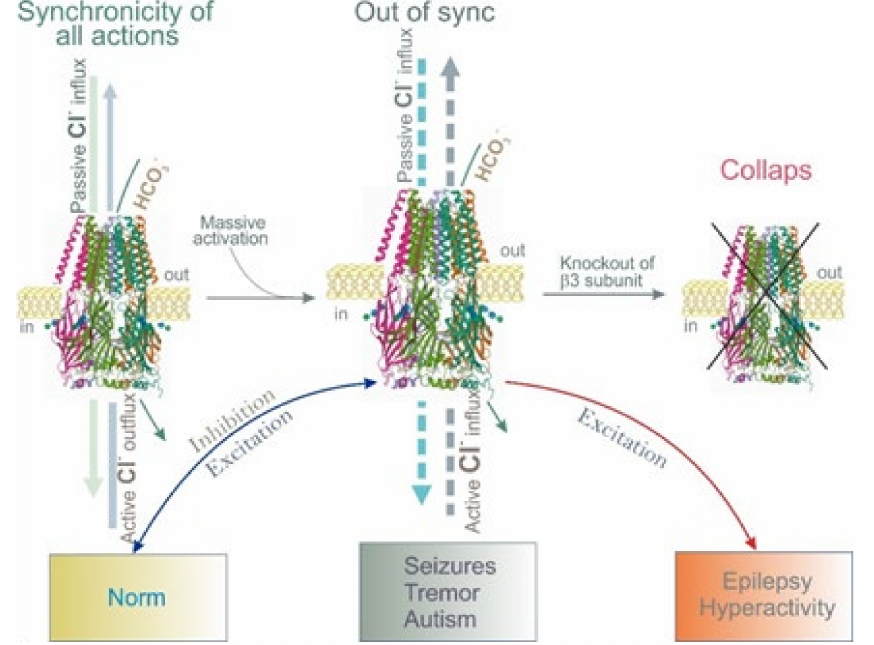
Figure 3. Role of the β 3 subunit in dissipated and generated Cl − gradients in norm and pathology. ( Left ) Schematic representation showing synchronicity work of passive and active Cl − fluxes via human GABA A B3R homopentamer (Protein Data Bank, 4COF) [93]. ( Middle ) Impaired synchronicity of multidirectional Cl − fluxes across receptor pores in certain circumstances (massive activation by GABA or other ligands). ( Right ) Collapse of Cl − moving via receptor pores lacking the β 3